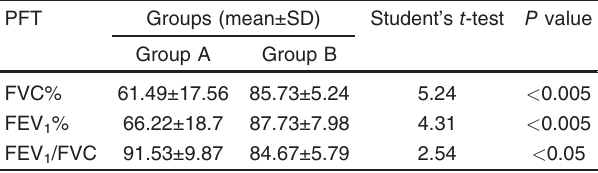
Table 3 Comparison between group A and group B regarding pulmonary